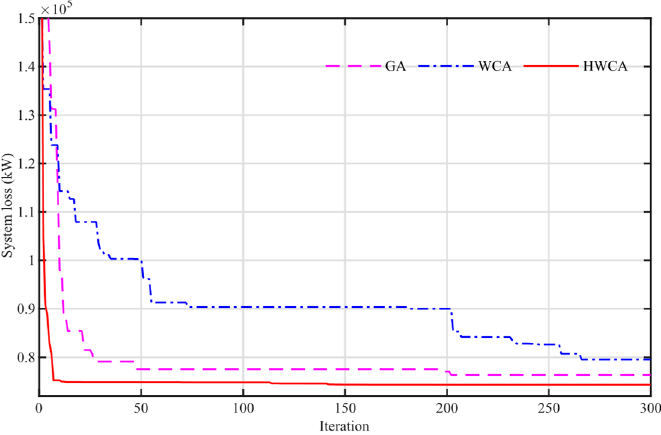
Figure 13. Convergence curve of the IEEE 33-node system using compared algorithms for cas.